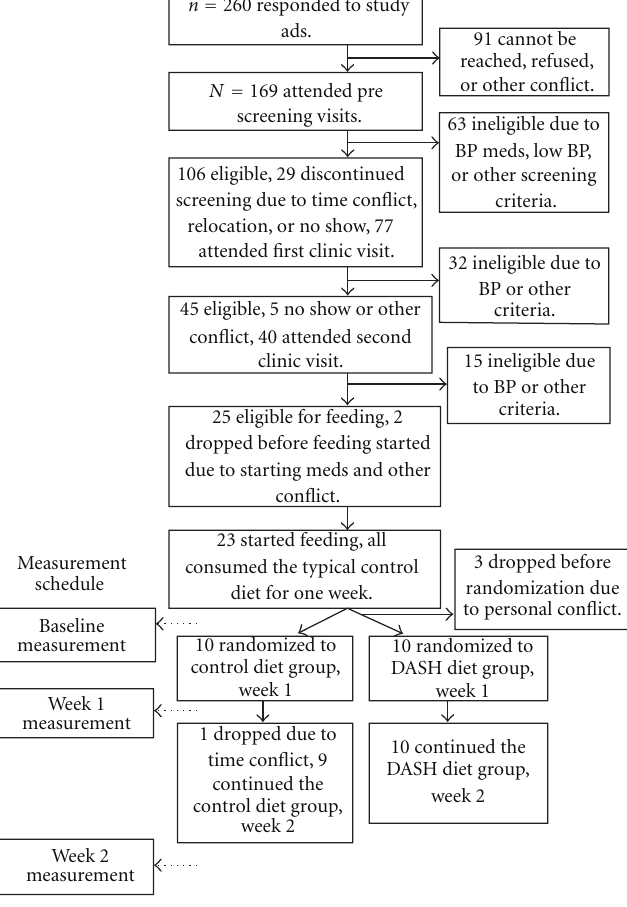
Figure 1: Design and flow of study.